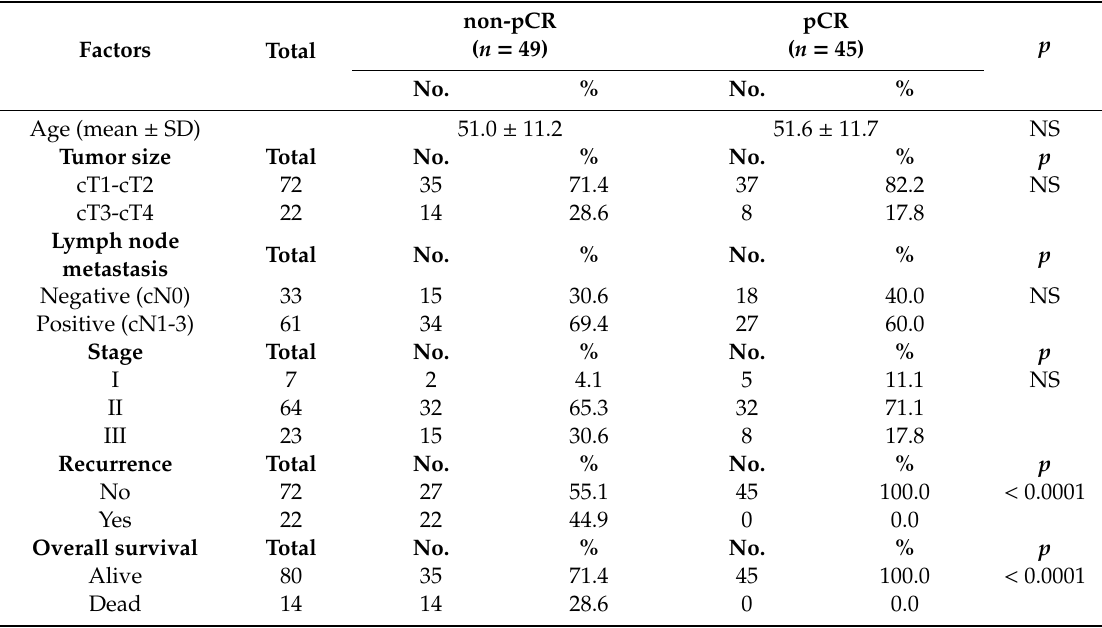
Table 4. Correlation of clinicopathological characteristics and